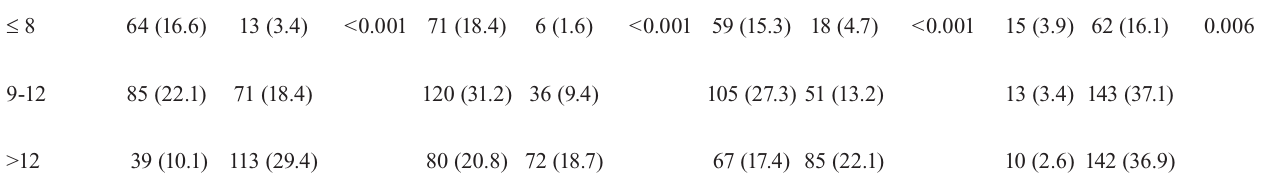
Table III represents the results of univariate days of hospital stay (p=0.045). Similarly, the risk of logistic regression analysis for exposure to >6 all >6 all types of pDDIs is 4.1 times higher in patients types of pDDIs and >4 major-pDDIs. In comparison prescribed 9-12 drugs (p=<0.001) and 14.3 times with ≤ 3 days of hospital stay, the risk of >6 all types higher in patients taking >12 drugs (p=<0.001) as of pDDIs increases by 1.8 times in patients with >6 compared with patients taking ≤ 8 drugs. Whereas,